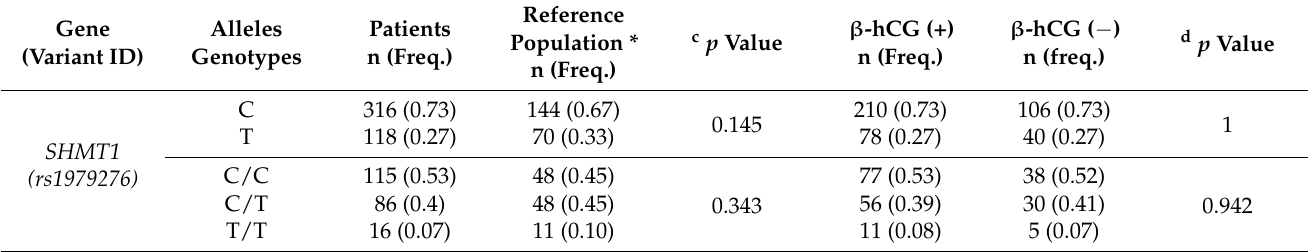
Table 2. Allele and genotype frequencies comparison between total study group and reference population * and the two largest groups of the cohort β -hCG (+) and β -hCG ( − ) recipients. Hardy– Weinberg equilibrium